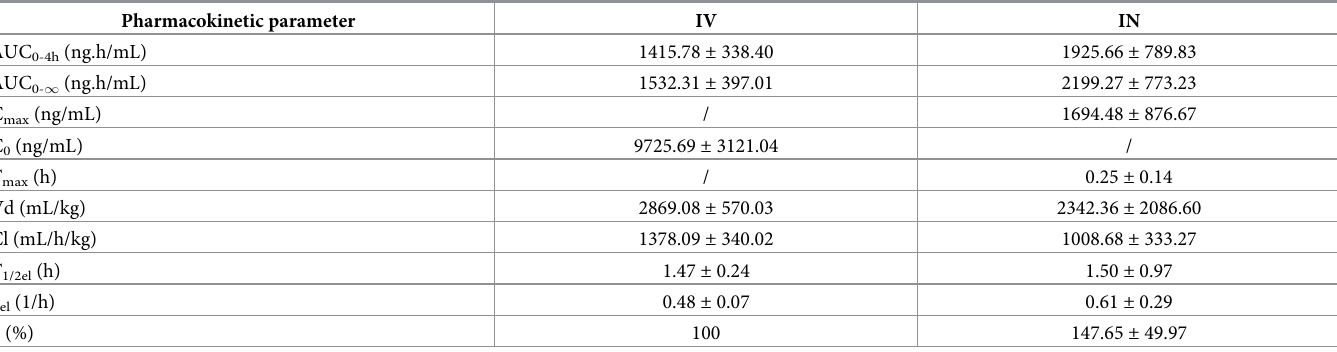
AUC 0-4h area under the plasma concentration-time curve from 0 to 4 hours post-administration; AUC 0- 1 area under the plasma concentration-time curve from 0 to infinity; C max maximal plasma concentration (IN); C 0 plasma concentration at time zero (IV); T max time to maximal plasma concentration (IN); Vd volume of distribution; Cl total body clearance; T 1/2el terminal elimination half-life; k el elimination rate constant. Vd and Cl values after IN administration were not corrected for IN bioavailability